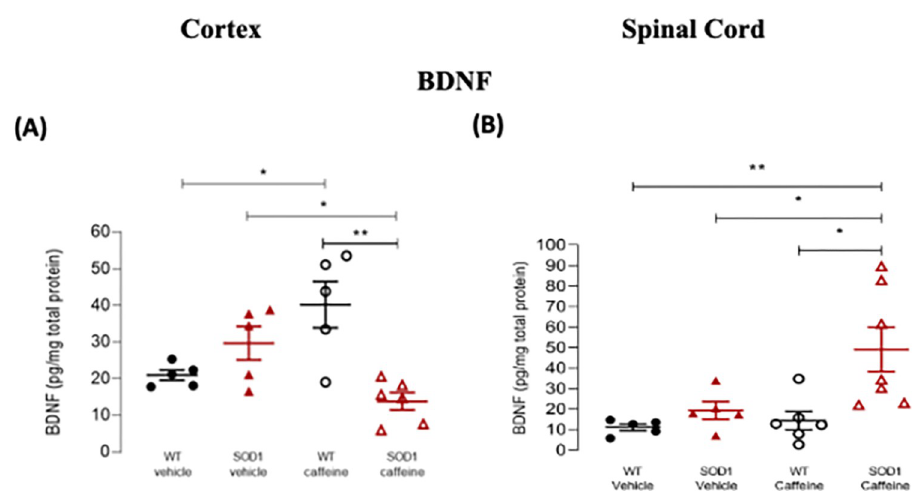
Fig 6. BDNF protein levels in the cortex and spinal cord of WT and SOD1 G93A mice treated/non-treated with caffeine. BDNF protein levels in samples from the cortex (A) or spinal cord (B) of late stage SOD1 G93A mice (16–18 weeks old) or age-matched WT mice, treated/non treated with caffeine, as indicated below each data set. The Y-axis represents the BDNF protein levels, determined by ELISA, in pg/mg of total protein. Caffeine administration in the drinking water (see methods) started when animals were 11 weeks old. Data are expressed as mean ± SEM (n = 4–6 animals); � p < 0.05, �� p � 0.01, two-way ANOVA with Holm-Sidak correction for multiple comparisons. SOD1 G93A mice with caffeine-treated WT mice (WT-CAF: 14.37 ± 4.488 pg/mg protein, SOD-CAF: 49.10 ± 10.82 pg/mg protein, p = 0.011). It is important to note, however the high